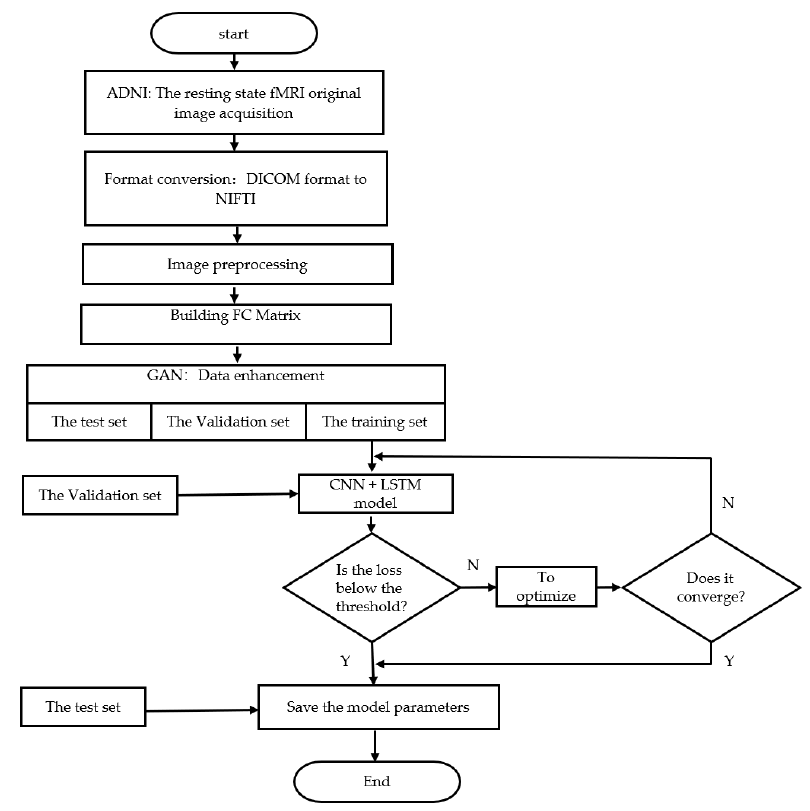
Figure 11. The overall program flow chart of this model .